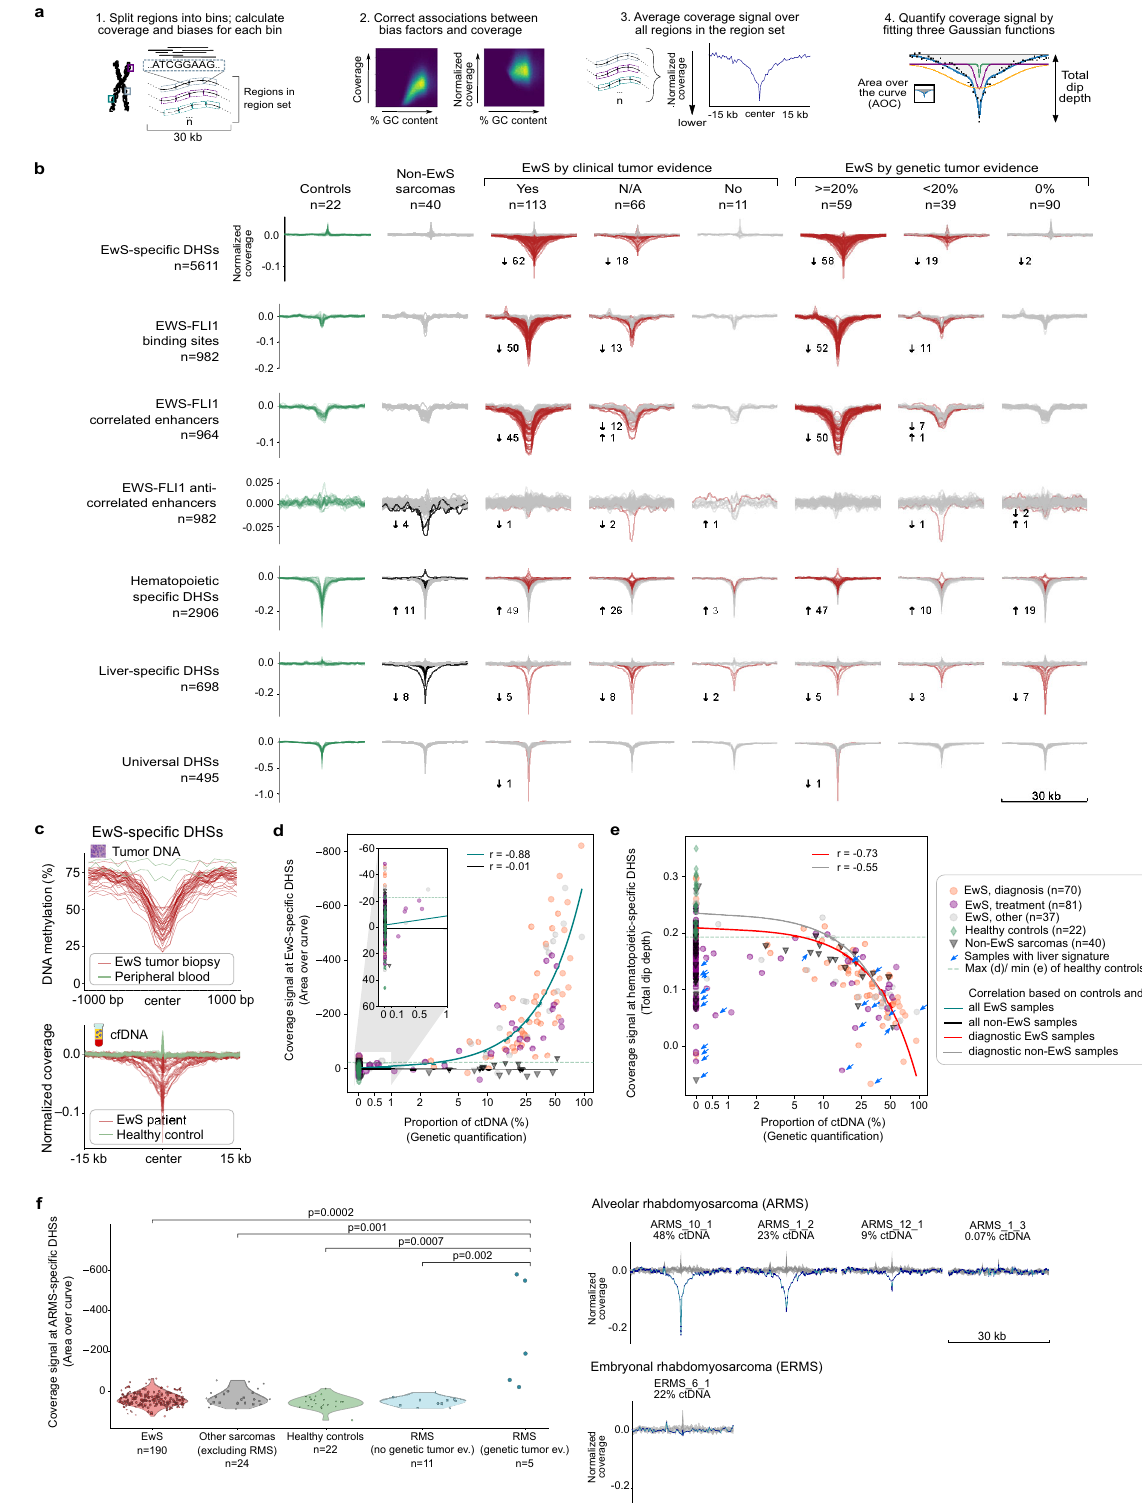
3. Average coverage signal over all regions in the region set